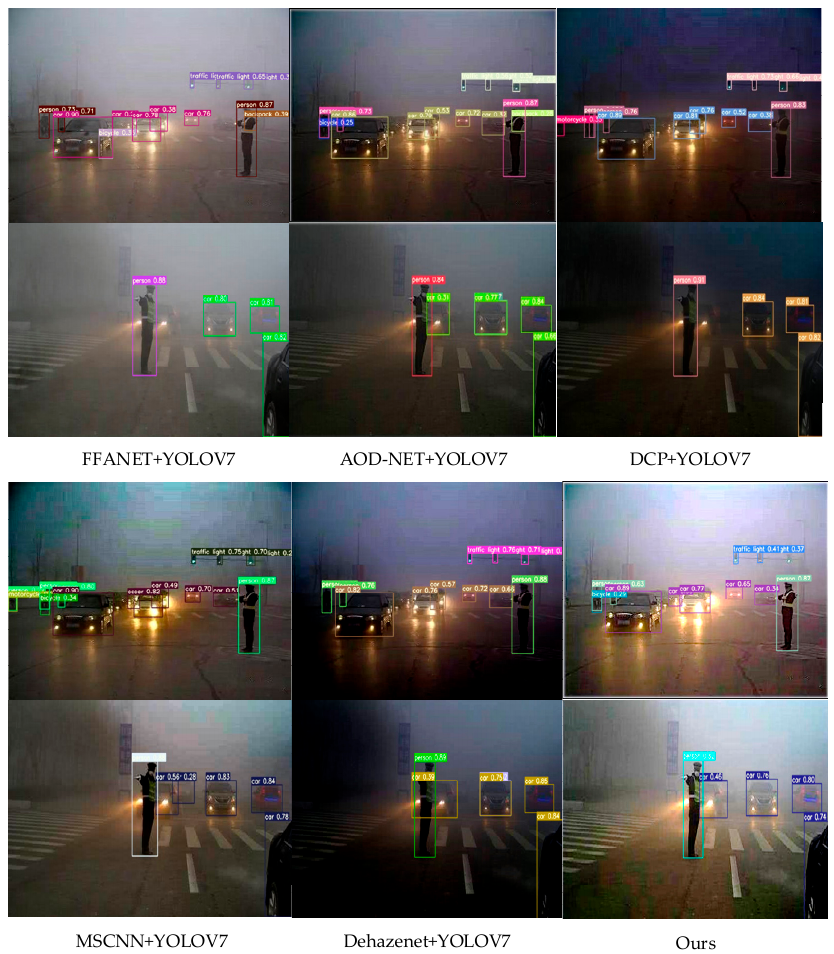
Figure 7. Object detection results on natural low-light foggy traffic images with a confidence thresh- old of 0.7, displayed on the dehazed results.